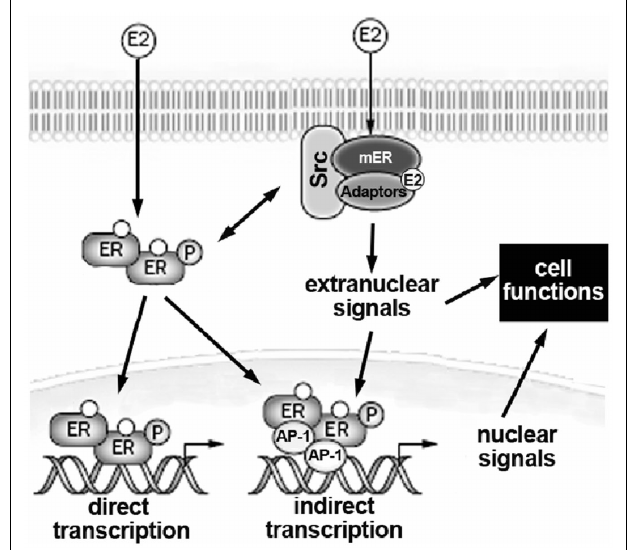
FIGURE 1 | Schematic model illustrating the relationship between extranuclear and nuclear actions of E2 on target cells. E2, 17 β -estradiol; mER, estrogen receptor located at the plasma membrane; ER, estrogen receptor; AP-1, activating factor-1. For details, see text.